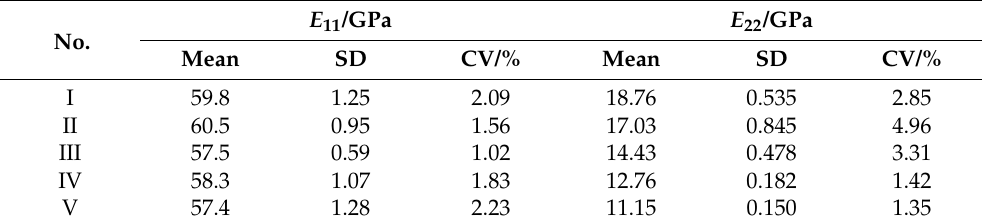
Figure 3. Longitudinal and transverse tensile–compression moduli of the five H-GFRP batches. ( a ) E 11 , ( b ) E 22 . Table 6. Statistical values of the longitudinal and transverse tensile − compression moduli of the five H-GFRP